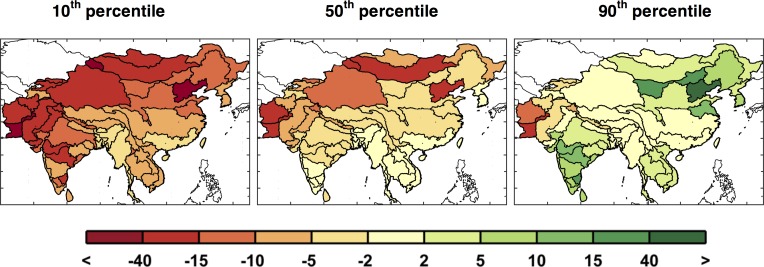
Changes in ASR runoff (%) calculated point-wise by ASR.These are changes in decadal averaged ASR runoff from the baseline to the future scenarios averaged over 2041–2050 for the 10th, 50th, and 90th percentiles.